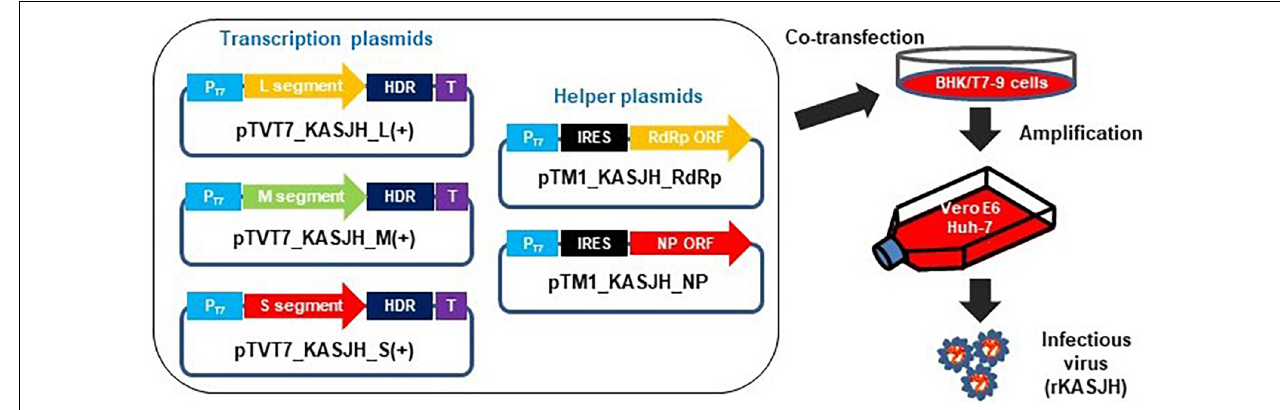
FIGURE 1 | Schematic describing the generation of recombinant SFTSV using a reverse genetics system. BHK/T7-9 cells were co-transfected with three transcription and two helper plasmids. rKASJH was rescued from the culture supernatants of transfected BHK/T7-9 cells, followed by passages on Vero E6 or Huh-7